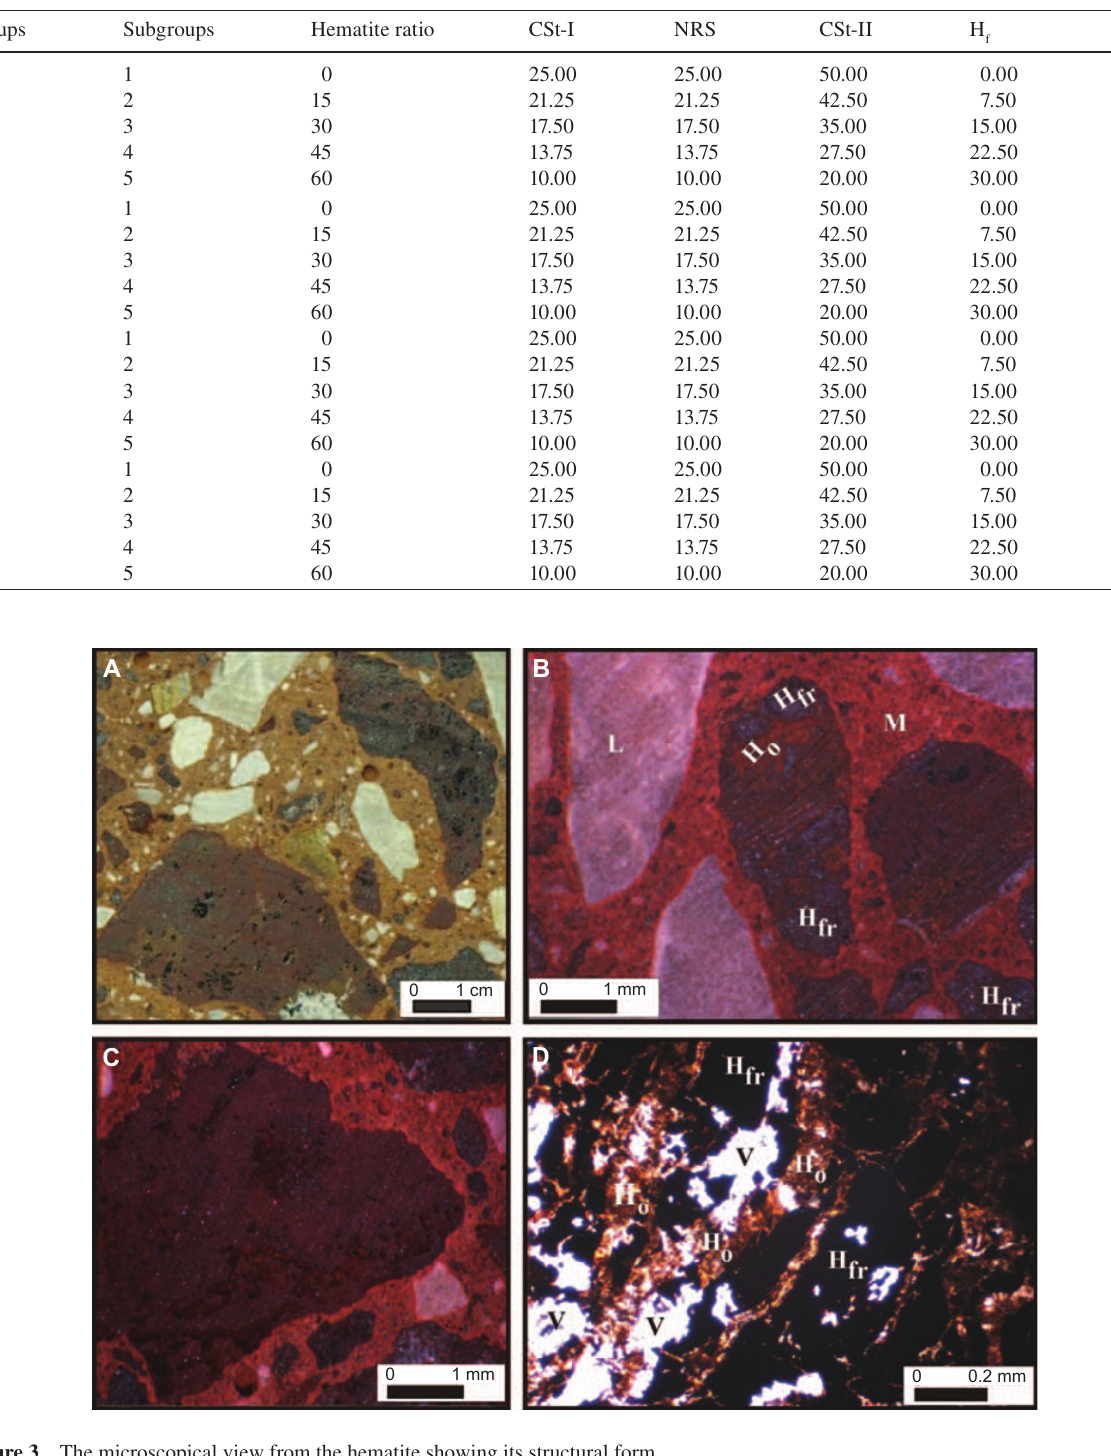
cement contents over 450 kg/m 3 may cause high and rapid hydration heat and potential consequent cracking. It is well known that cracks in concrete negatively affect shielding